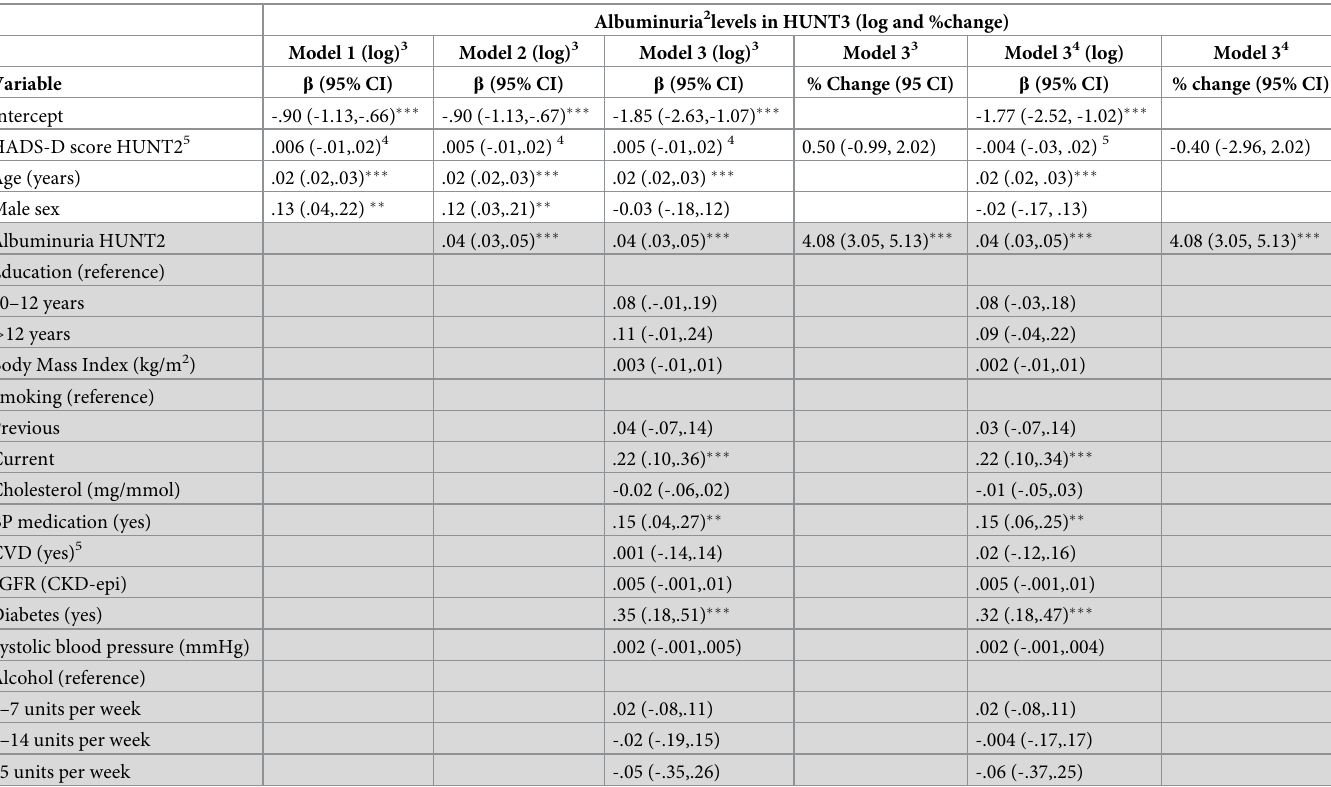
Table 4. General linear regression 1 of the effects of depression symptoms in HUNT2 on albuminuria in